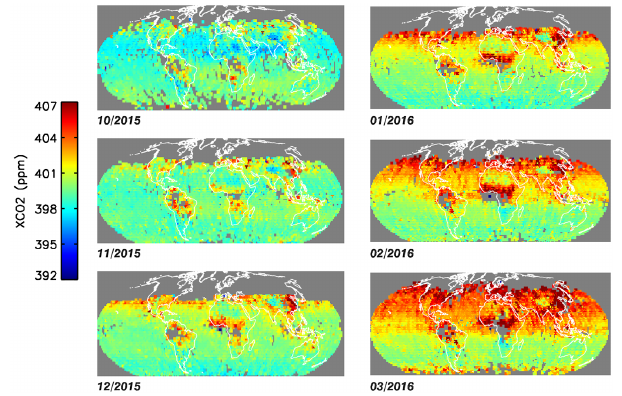
Figure 5. Maps of X CO from OCO-2 from October 2015 through 2 March 2016, bias corrected and selected with data quality flag and averaged on 2 ◦ by 2 ◦